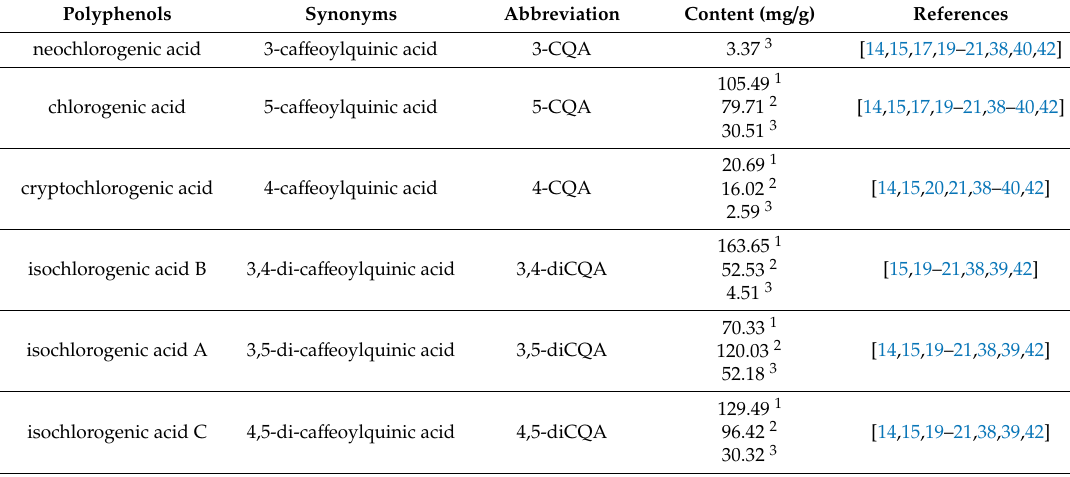
Table 1. Chlorogenic acid and its derivatives are the six major polyphenols in Kuding